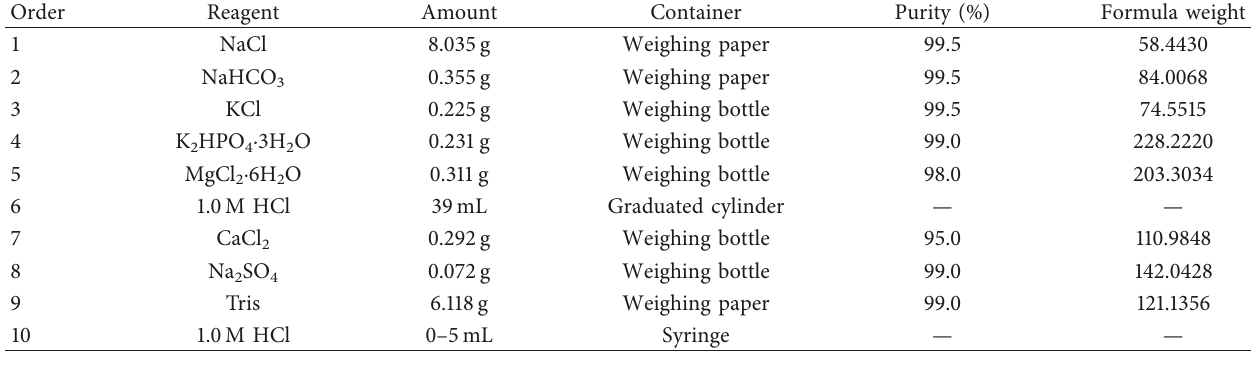
Table 1: Order, amounts, weighing containers, purities, and formula weights of reagents for the preparation of 1L of SBF. Order